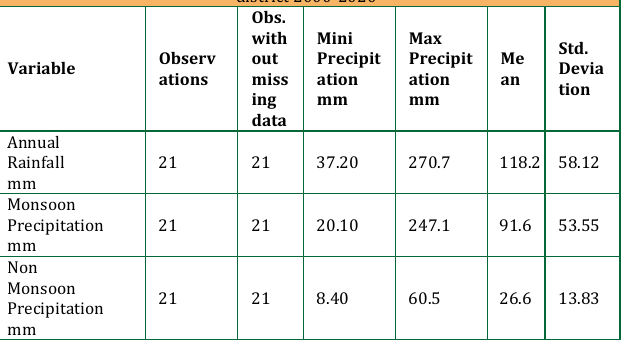
Table 1: Summary statistics of Annual and Seasonal Precipitation mm of Ghotki district 2000-2020